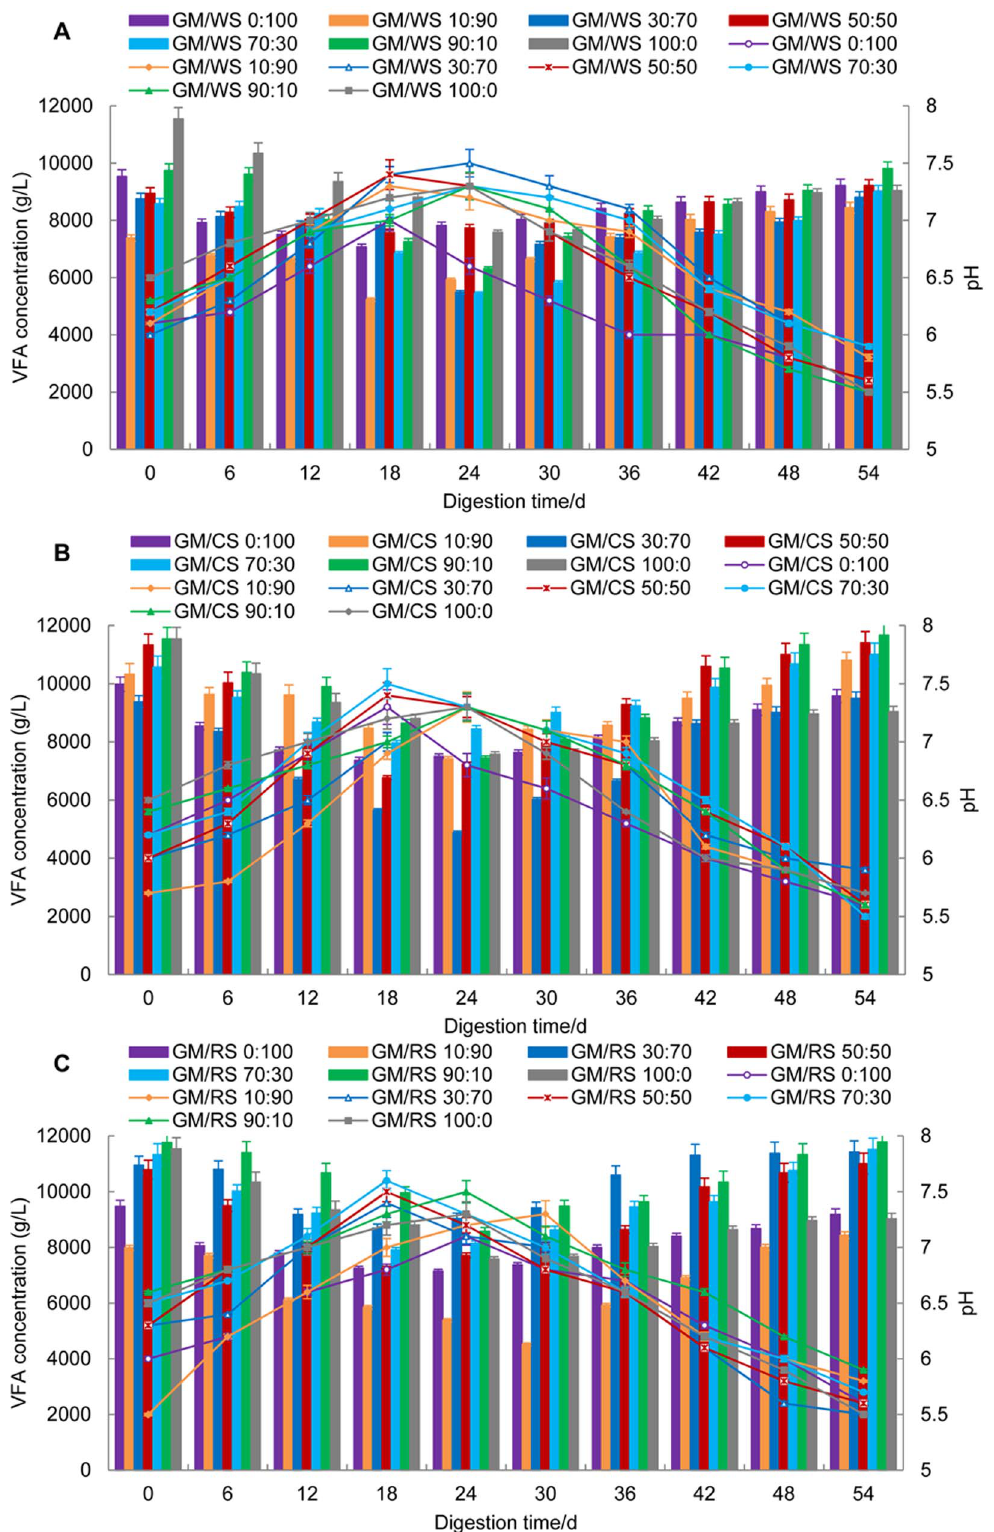
Figure 4. VFA concentrations and pH values from the co-digestion of GM and WS (A), CS (B) and RS (C) with different mixing ratios. Mean values originated from three independent replications. Columns represent VFA, lines represent pH values, and vertical bars represent standard deviations. VFA, volatile fatty acid.